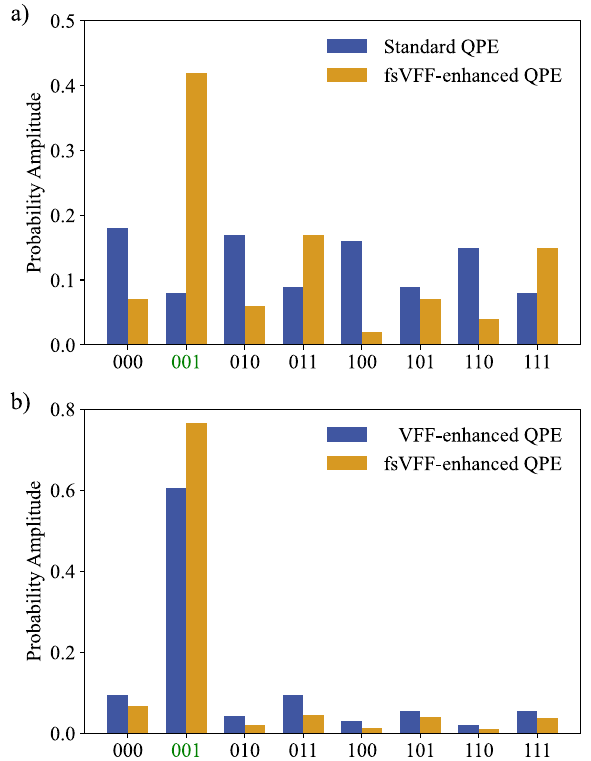
Fig. 9 Quantum Phase Estimation. a Hardware Implementation. Using the 2-qubit diagonalization found from training on ibmq_tor- onto, QPE was performed on ibmq_boeblingen on the eigenvector E 1 j i : ¼ 1 ffiffi p ð 01 j i þ 10 j iÞ . A phase of e 2 π i 8 is applied, so the measured 2